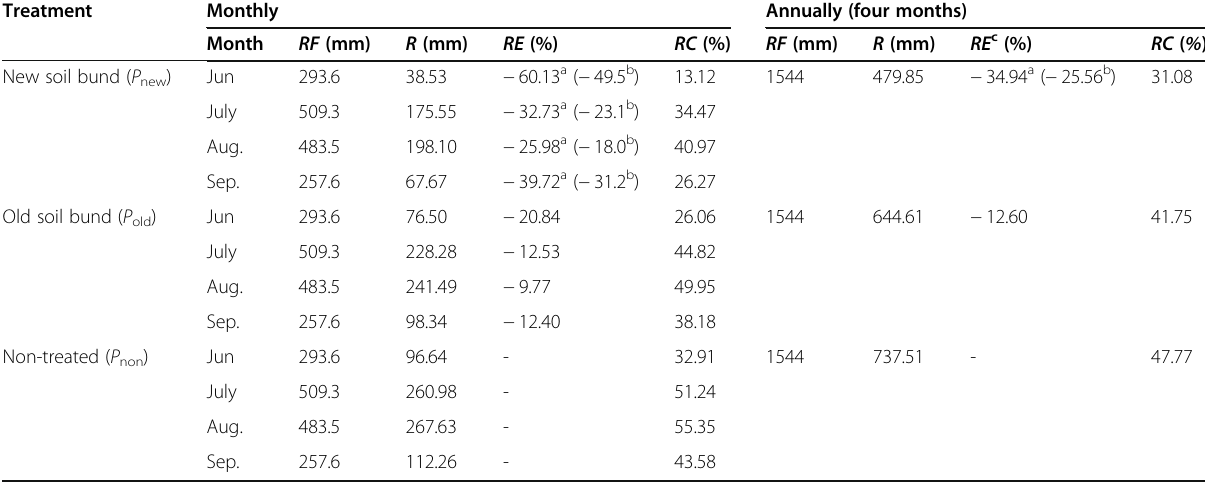
Table 1 Monthly and annual rainfall ( RF ), runoff ( R ), runoff coefficient ( RC ), and the relative effect ( RE ) of conservation measures Treatment Monthly